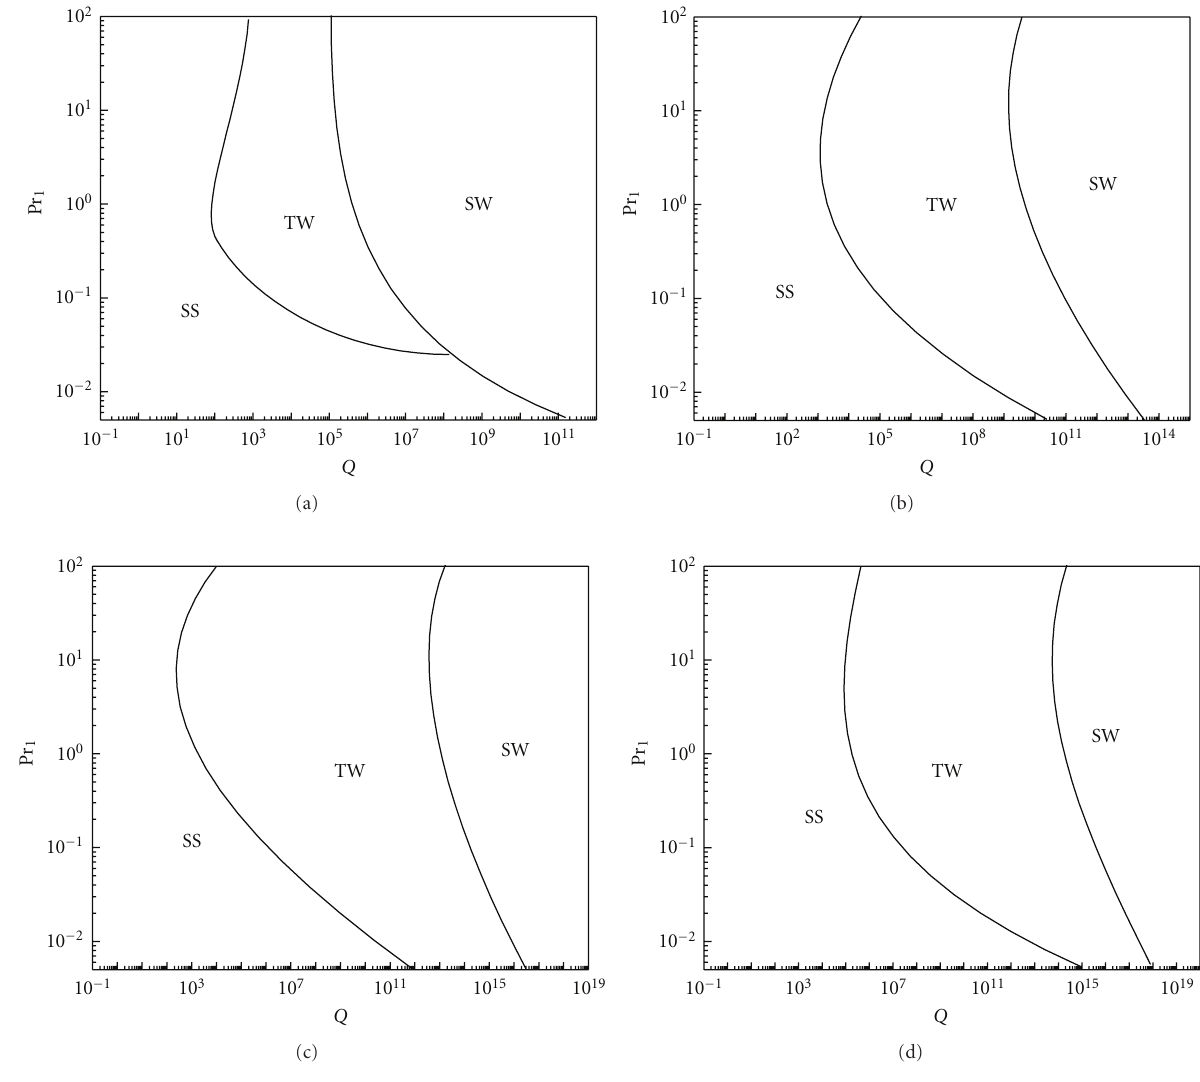
Figure 7: Figures (a–d), are plotted for Pr 2 / Pr 1 = 6,12,18, and 24, respectively, and for fixed parameters D a = 1500, Λ = 0 . 85, φ = 0 . 9, and M = 0 . 9. Stability regions of steady state (SS), travelling waves (TW), and standing waves (SW) are plotted ( Q ,Pr 1 )-plane.